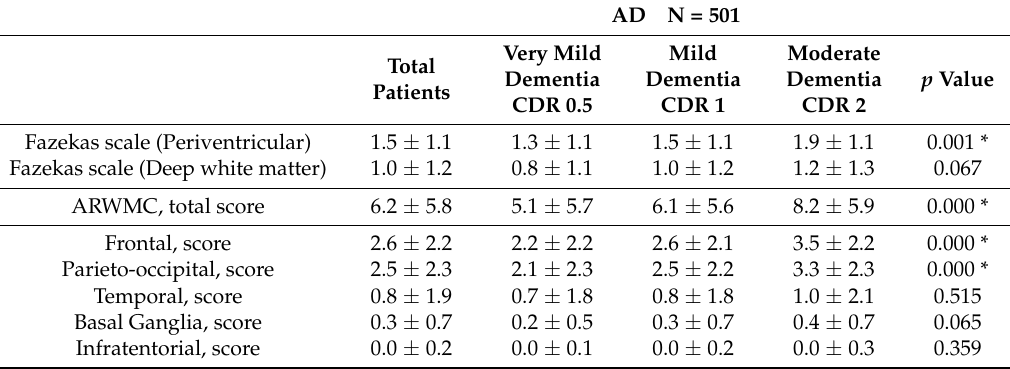
Table 3. Relationship between white matter changes and the severity of Alzheimer’s disease.